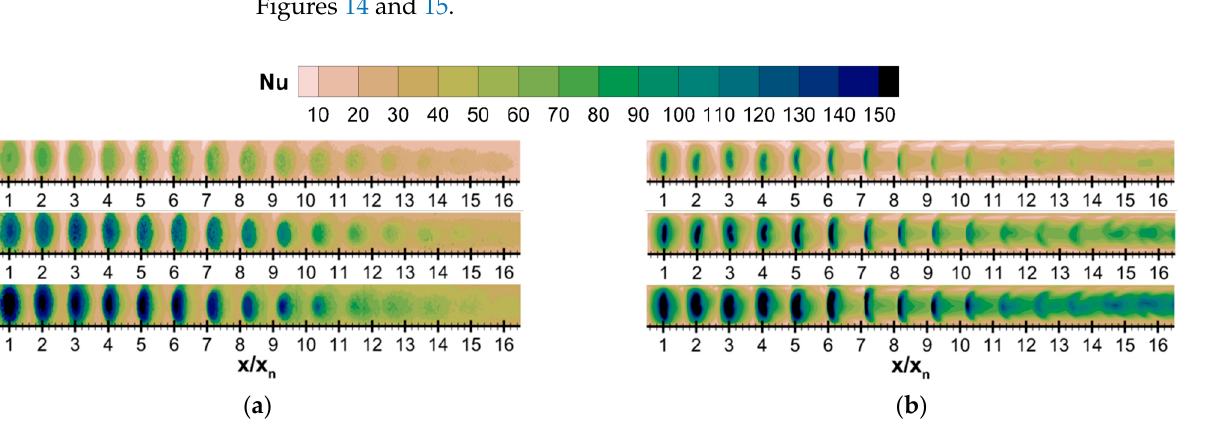
Figure 14. Local distributions of Nu for the baseline configuration, from top to bottom: Re j = 1.0 × 10 4 , 2.0 × 10 4 and 3.0 × 10 4 ; ( a ) Exp; ( b ) CFD.